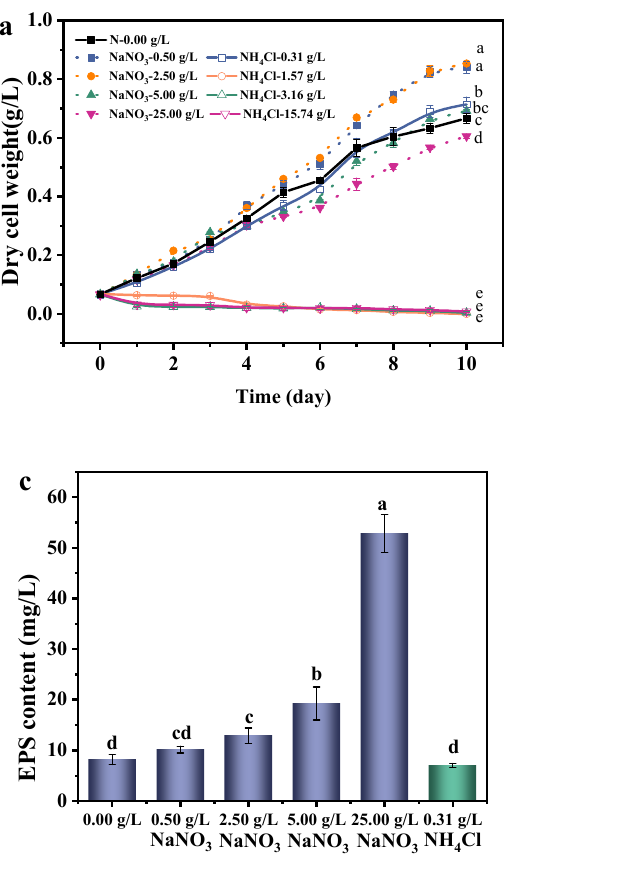
Figure 4. The effects of nitrogen source and concentration on the growth and EPS secretion of A. platensis : ( a ) Growth curves; ( b ) Biomass production and growth rate; ( c ) EPS content; ( d ) EPS yield; DW: dry weight; a–e: Different letters above the bars indicated a significant difference among the groups. Points showed average of three independent measurements; vertical bars indicated the standard deviation. ( p < 0.01, n =